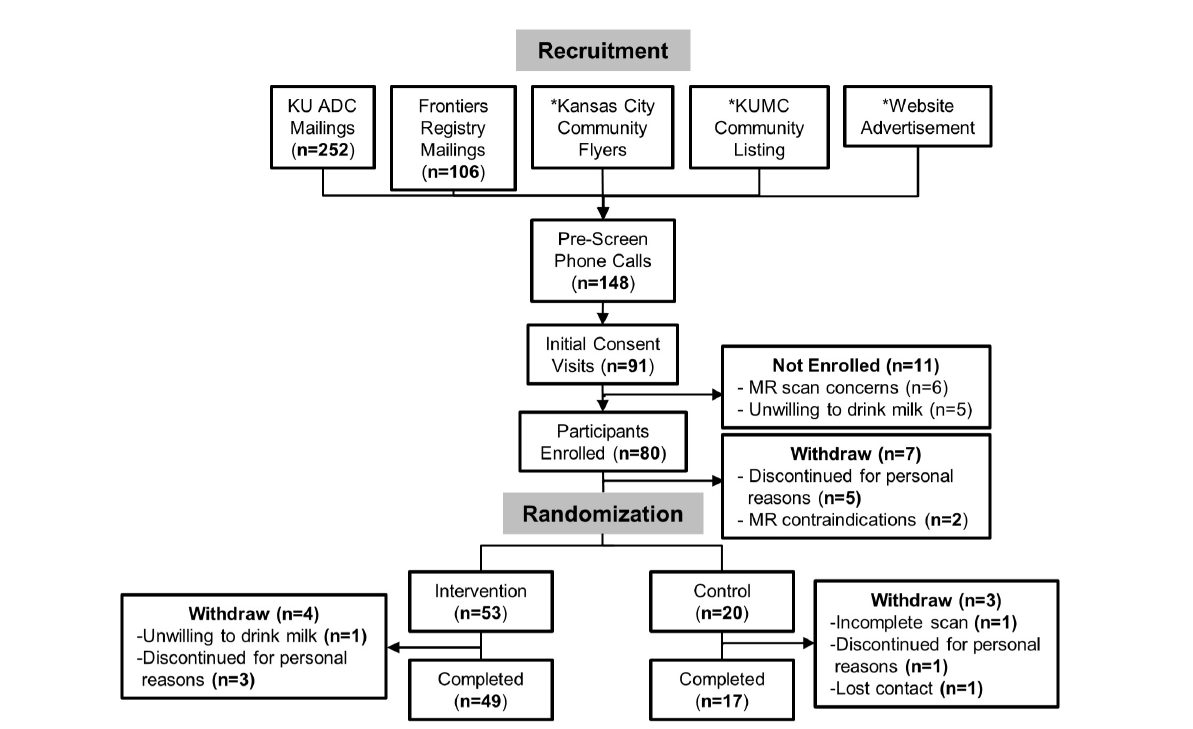
FIGURE1 CONSORT diagram for MILK study recruitment and analysis. *We are unable to assess the number of individuals that came into contact with flyers and online study advertisements.